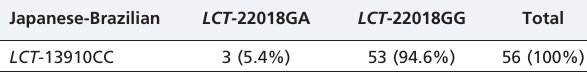
Table 1- Genotypic distribution of lactase persistence/ hypolactasia in